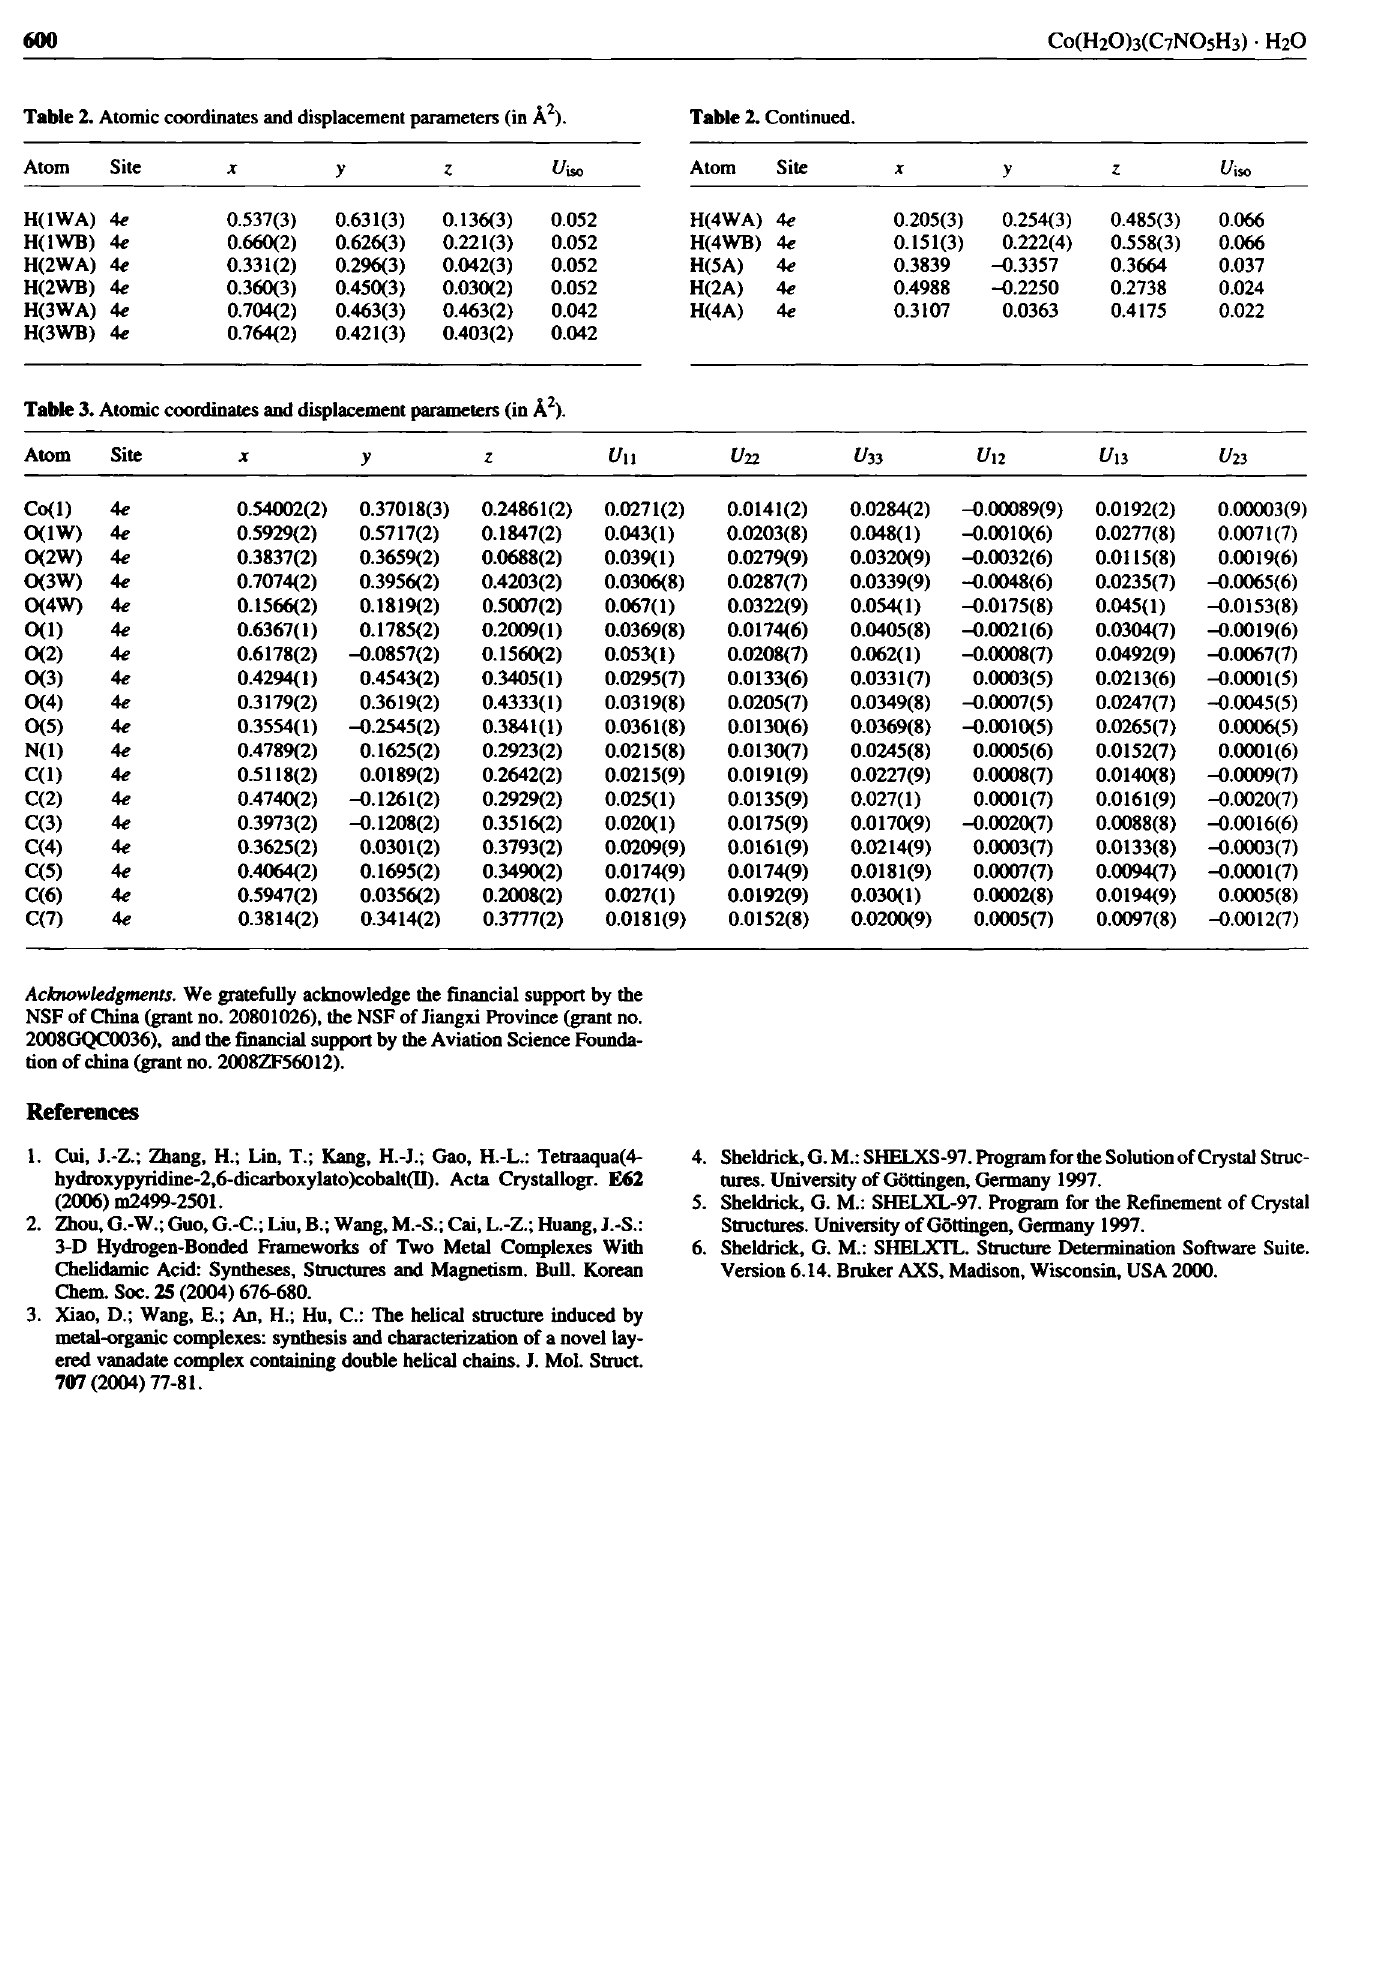
Table 3. Atomic coordinates and displacement parameters (in Â 2